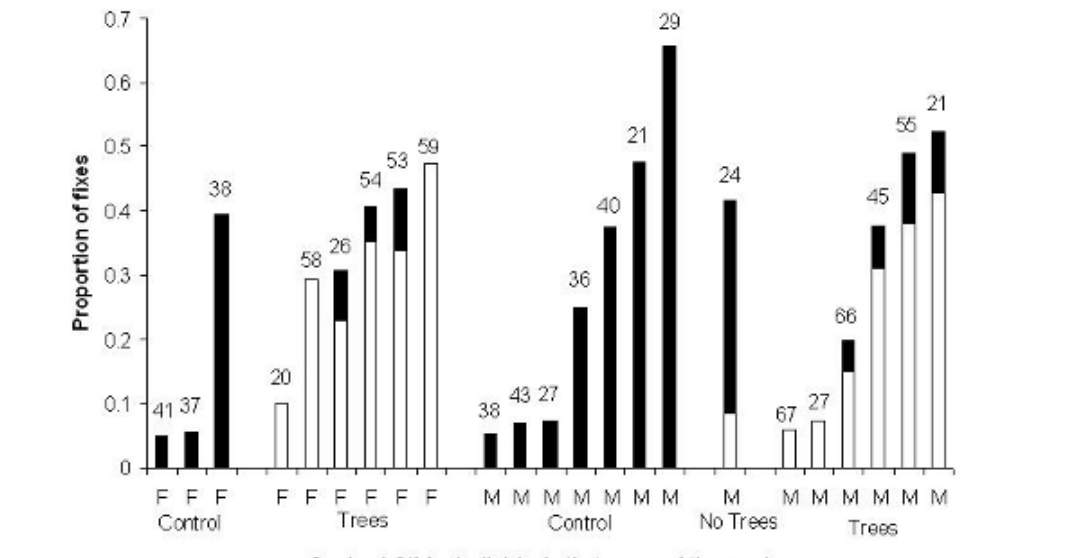
Fig. 5. Proportion of fixes for 23 squirrel gliders ( Petaurus norfolcensis ) that made partial (clear columns) and complete (solid columns) crossings of the Hume Freeway at sites with and without tall trees in the centre median (Trees and No Trees, respectively) and secondary roads (Control). Sex of individuals is given on X-axis and total number of detections given above each column. Data for animals that were not detected crossing is not